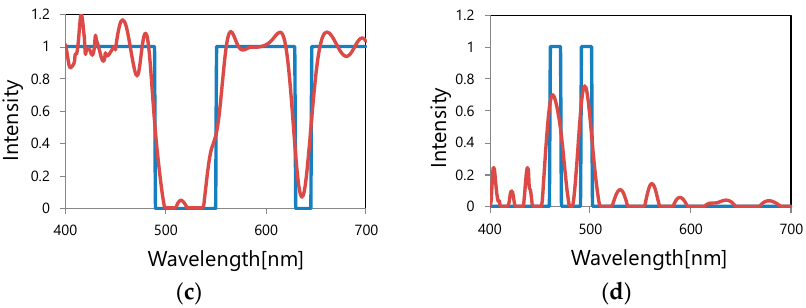
Figure 6. Simulation of spectral reconstruction (Blue line: Designed spectrum; red line: Reconstructed spectrum). ( a ) Single band spectrum near 700 nm in wavelength; ( b ) single band spectrum at a center wavelength of 500 nm; ( c ) multiple band-stop spectrum; ( d ) multiple peak spectrum.